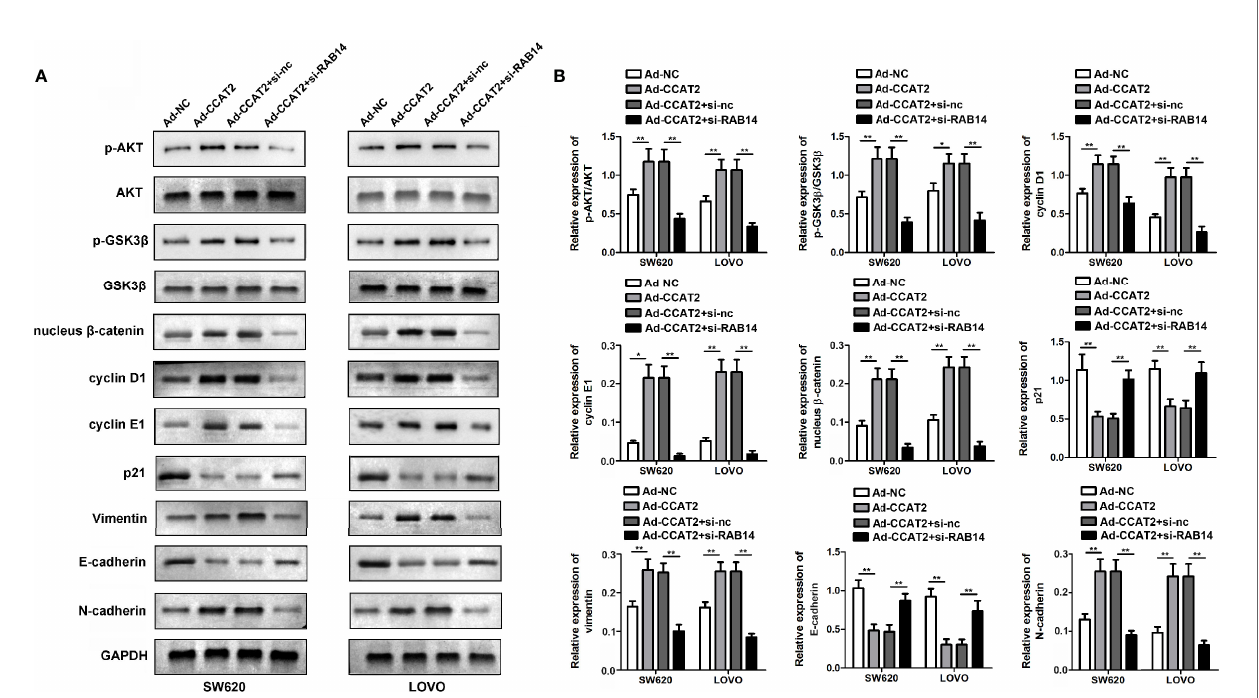
FIGURE 7 | CCAT2 activated the AKT/GSK3 b signaling pathway, promoted cell cycle and EMT, while these effects were rescued by RAB14. (A, B) Phosphorylation levels of AKT/GSK3 b in response to ectopic CCAT2 in SW620 and LOVO cells. The Relative fold change in phosphorylation was calculated by the ratio of the phosphorylation signal over total protein signal of AKT and GSK3 b . Simultaneously, the expressions of cell cycle and EMT-related factors were also quanti fi ed. The endogenous levels of GAPDH protein were used for normalization. The data are represented as mean ± SD. Three independent biological repeats were used for each analysis. *P < 0.05, **P <